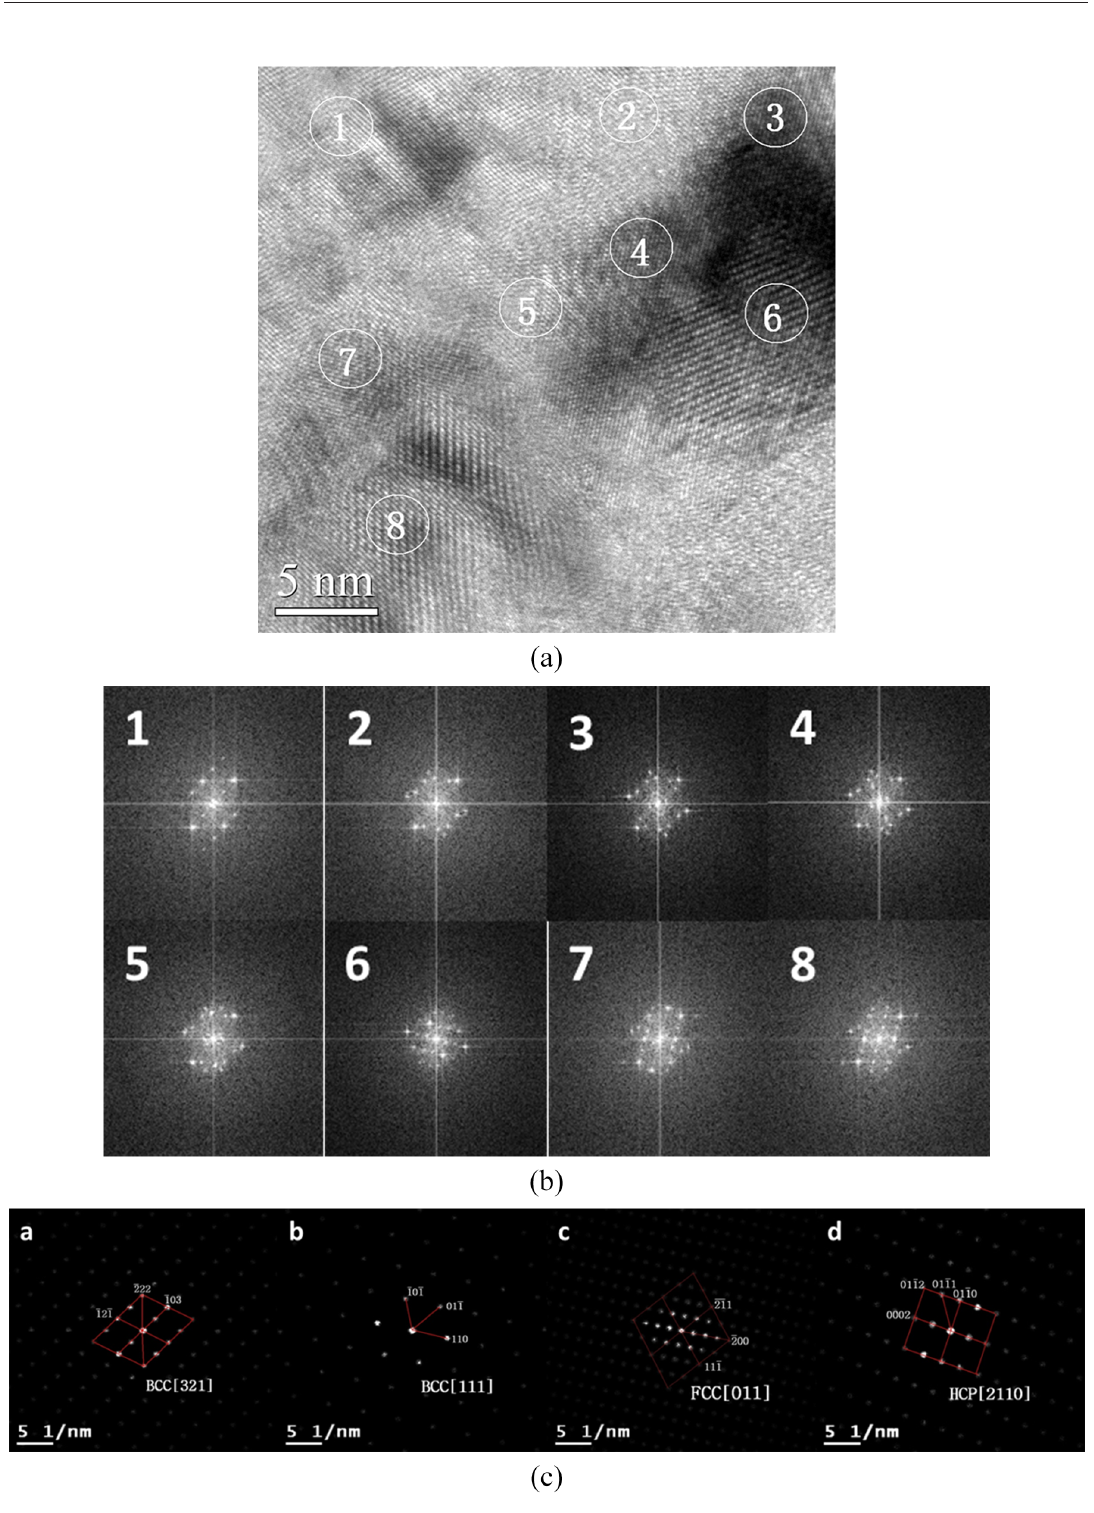
Figure 8. 5μm Fe-11.7Mn alloy powder (a) HRTEM, (b) Fast Fourier Transform (FFT), (c) Bragg filter.